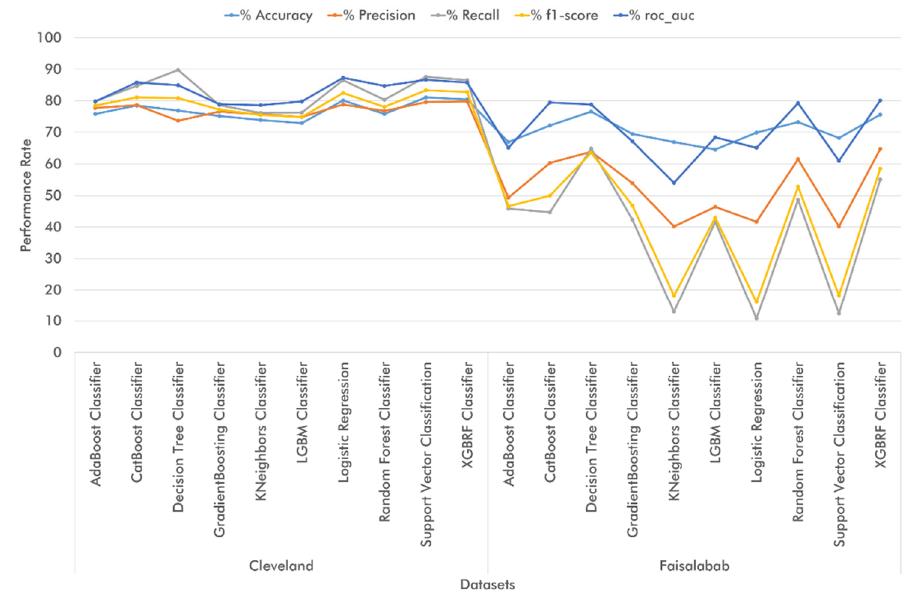
Figure 6. K-fold cross-validation performance of ten ML classifiers on the top-four features of the Cleveland and the Faisalabad datasets.